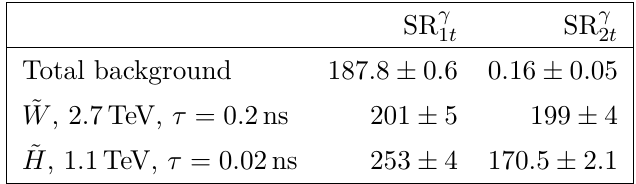
Table 3. Expected numbers of events in the signal regions for an integrated luminosity of 10 ab − 1 √ of s = 10 TeV muon collisions. Statistical uncertainties due to the number of generated events are